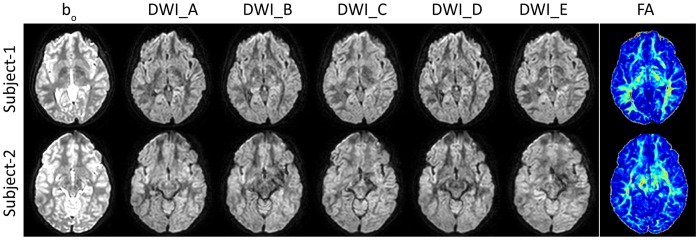
Example input and output data for two subjects from Study II.The DWIs were randomly chosen by a computer but are from the same gradient for each subject. DWIs and bo are shown at different intensity scales for viewing purposes. The FA color scale ranges from [blue-red] and colors map to FA values [0 1]. Inter-subject registration was not performed and the axial slices are from approximate matching locations. The FA map of subject 2 contains an anomalous bright region in the middle-right mid-brain/hemisphere (patient right is image right). This bright region is not clearly traced to DWI artifacts, but upon comparison to a re-scan of the same individual is associated with flow artifacts rather than pathology.